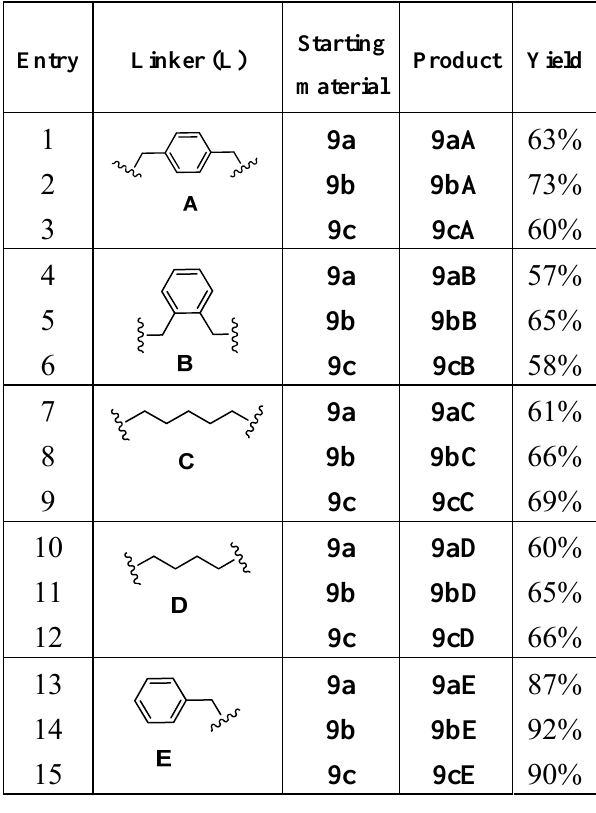
Table 2. Linkers used for synthesis of dimers 9aA-9cE. Entry Linker (L)